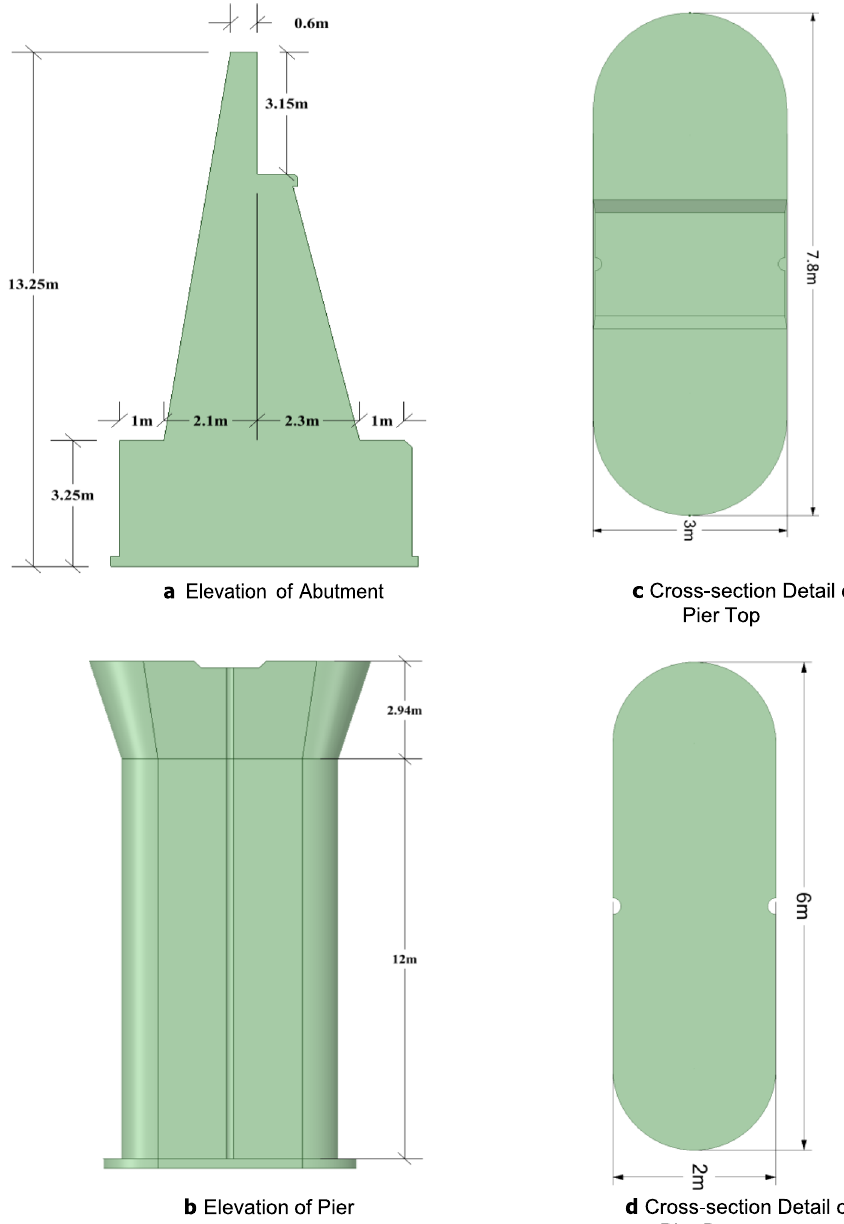
Fig. 3 a Elevation of Abutment; c Cross-section Detail of Pier Top; b Elevation of Pier; d Cross-section Detail of Pier